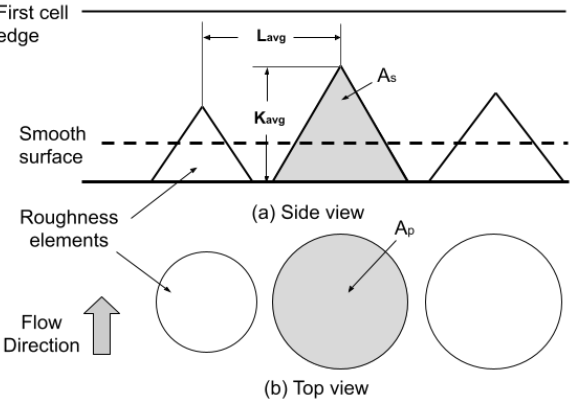
Figure 1. Roughness element geometrical